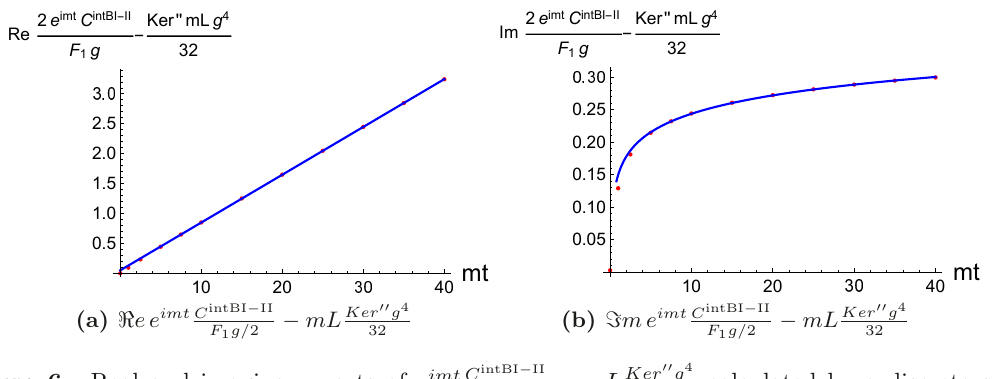
Figure 6. Real and imaginary parts of e imt C intBI − II